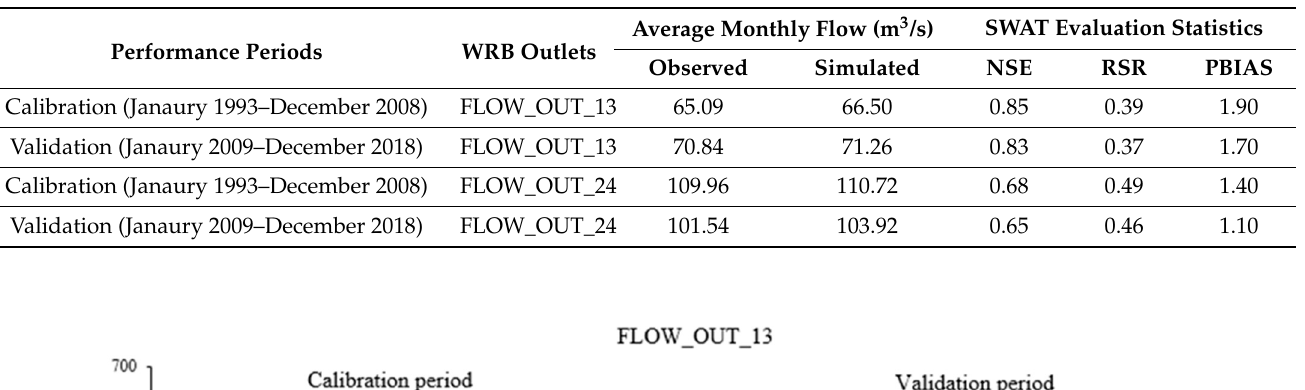
Table 11. The model performance statistics for calibration and validation in the two outlets of the WRB.